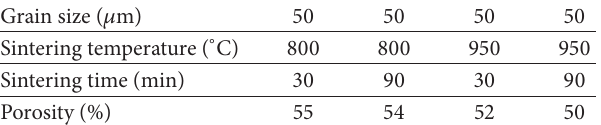
Table 3: Porosity of sintered structures from nickel powder with grain size of 10 𝜇 m.